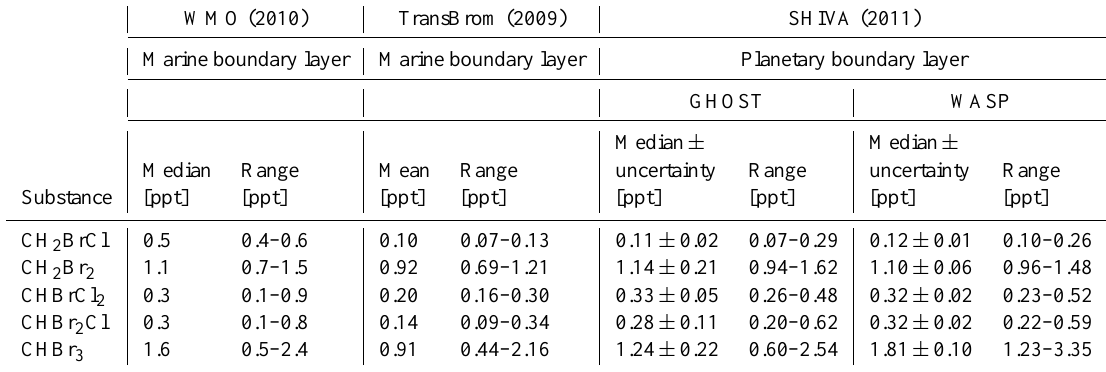
Table 6. Comparison of the boundary layer measurements during SHIVA derived independently from GHOST (GUF) and WASP (UEA) instrument with data compiled in Montzka and Reimann et al. (2011) and data from the TransBrom ship campaign (Brinckmann et al., 2012). The measurement uncertainty (1 σ ) of the SHIVA data is the sum of scale accuracy and instrumental measurement precision, excluding atmospheric variability. The range for the SHIVA data represents the 2.5 to 97.5 percentiles of the observed distribution.